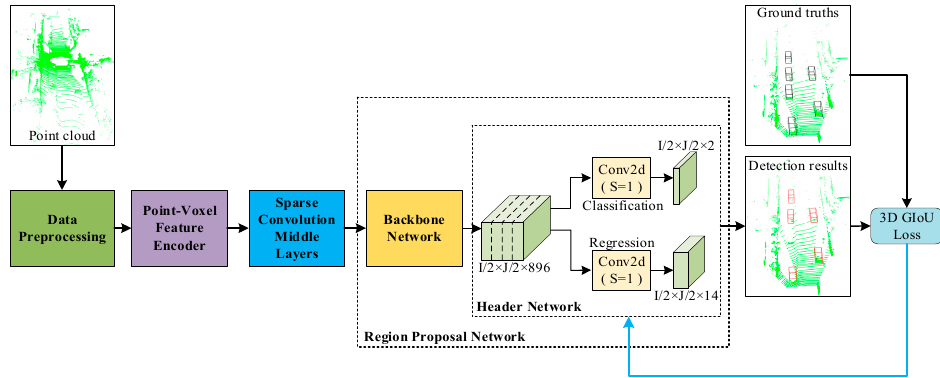
Figure 1. Three-Dimensional Generalized Intersection over Union (3D-GIoU) Architecture. The network takes point cloud as input. After the point cloud is discretized into 3D voxel grids, Point-Voxel Feature Encoder is used to learn voxel-wise features. Then, these features are processed by Sparse Convolution Middle Layers and sent to the Region Proposal Network to predict the classification score and the bounding box regression map. Last, the detection results and ground truth bounding boxes are used to calculate 3D GIoU loss, and 3D GIoU loss is used for optimizing the bounding box regression.